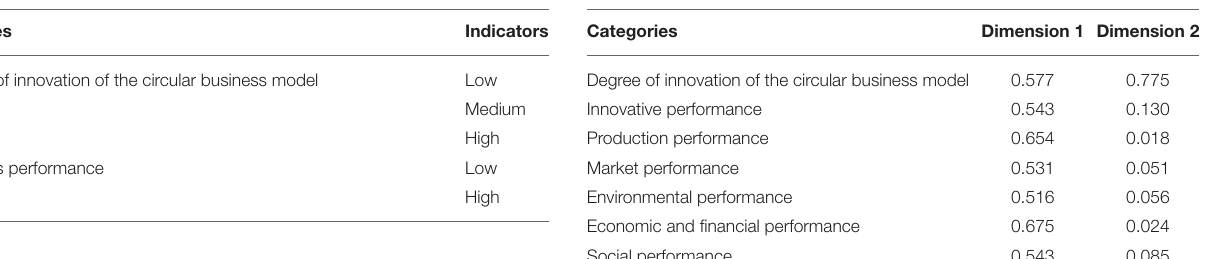
Circular Business Model and Performance